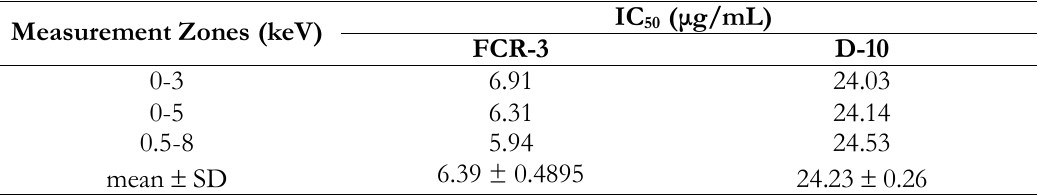
Table III. IC 50 value of 8-hydroxyisocapnolactone-2  3  -diol of chloroquine-resistant (FCR-3) and chloroquine-sensitive (D-10) P. falciparum on the three measurement